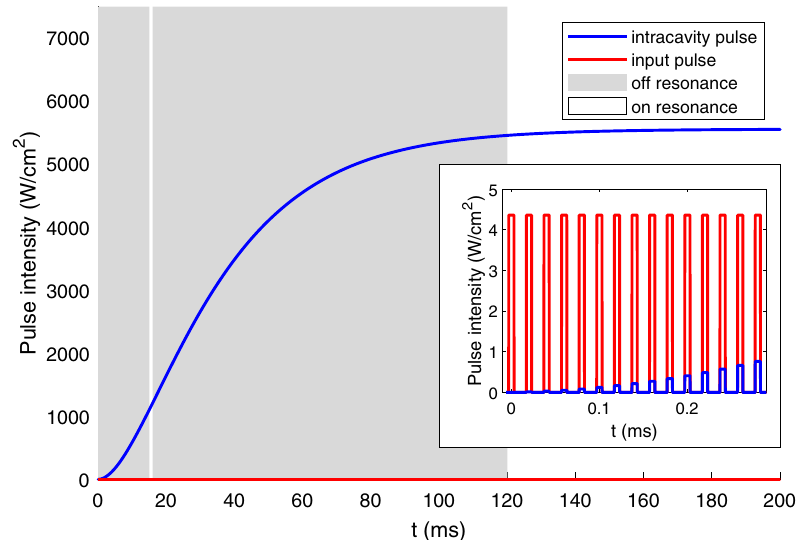
Fig. 2 Cavity build up. Cavity response to a periodic train of spatially resolved coherent square pulses as a function of time. The input intensity I in is plotted in red and the intracavity intensity I circ in blue. The main plot shows the intensity maxima of the input and circulating pulses. The inset shows the full time- dependence for the fi rst 15 input pulses. The system parameters match those described in the text, L = 6 km, F ¼ 4000, τ = 6 μ s. The intracavity intensity increases as input pulses coherently add, before saturating at its stationary cavity-enhanced value, which is exactly that of a π -pulse. Grey-shaded areas indicate when the light is off-resonance with the atomic transition. It is shifted on-resonance for one round trip at t = 15 ms to drive the initial π /2-pulse, and again after 120 ms to perform the large momentum transfer